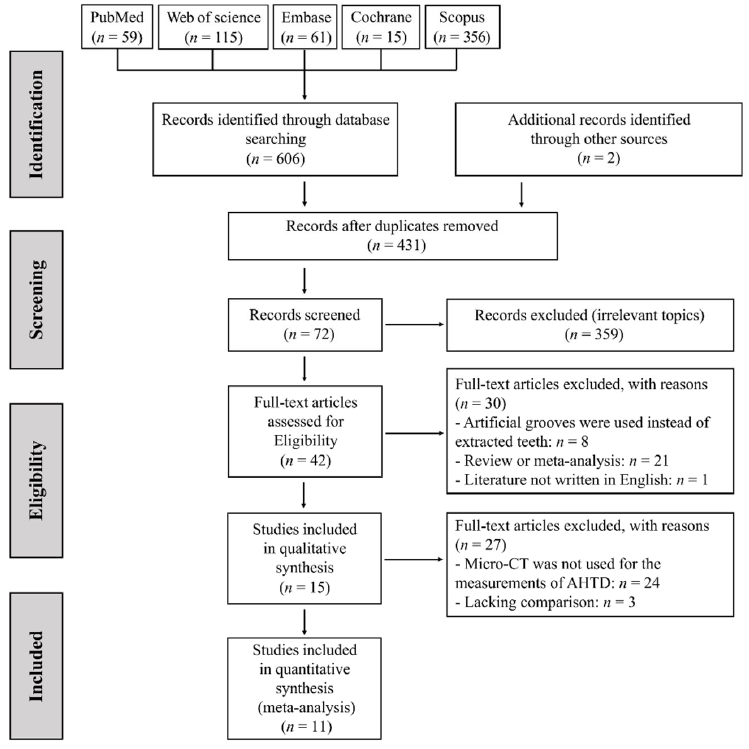
Figure 1. PRISMA flow chart of study selection.